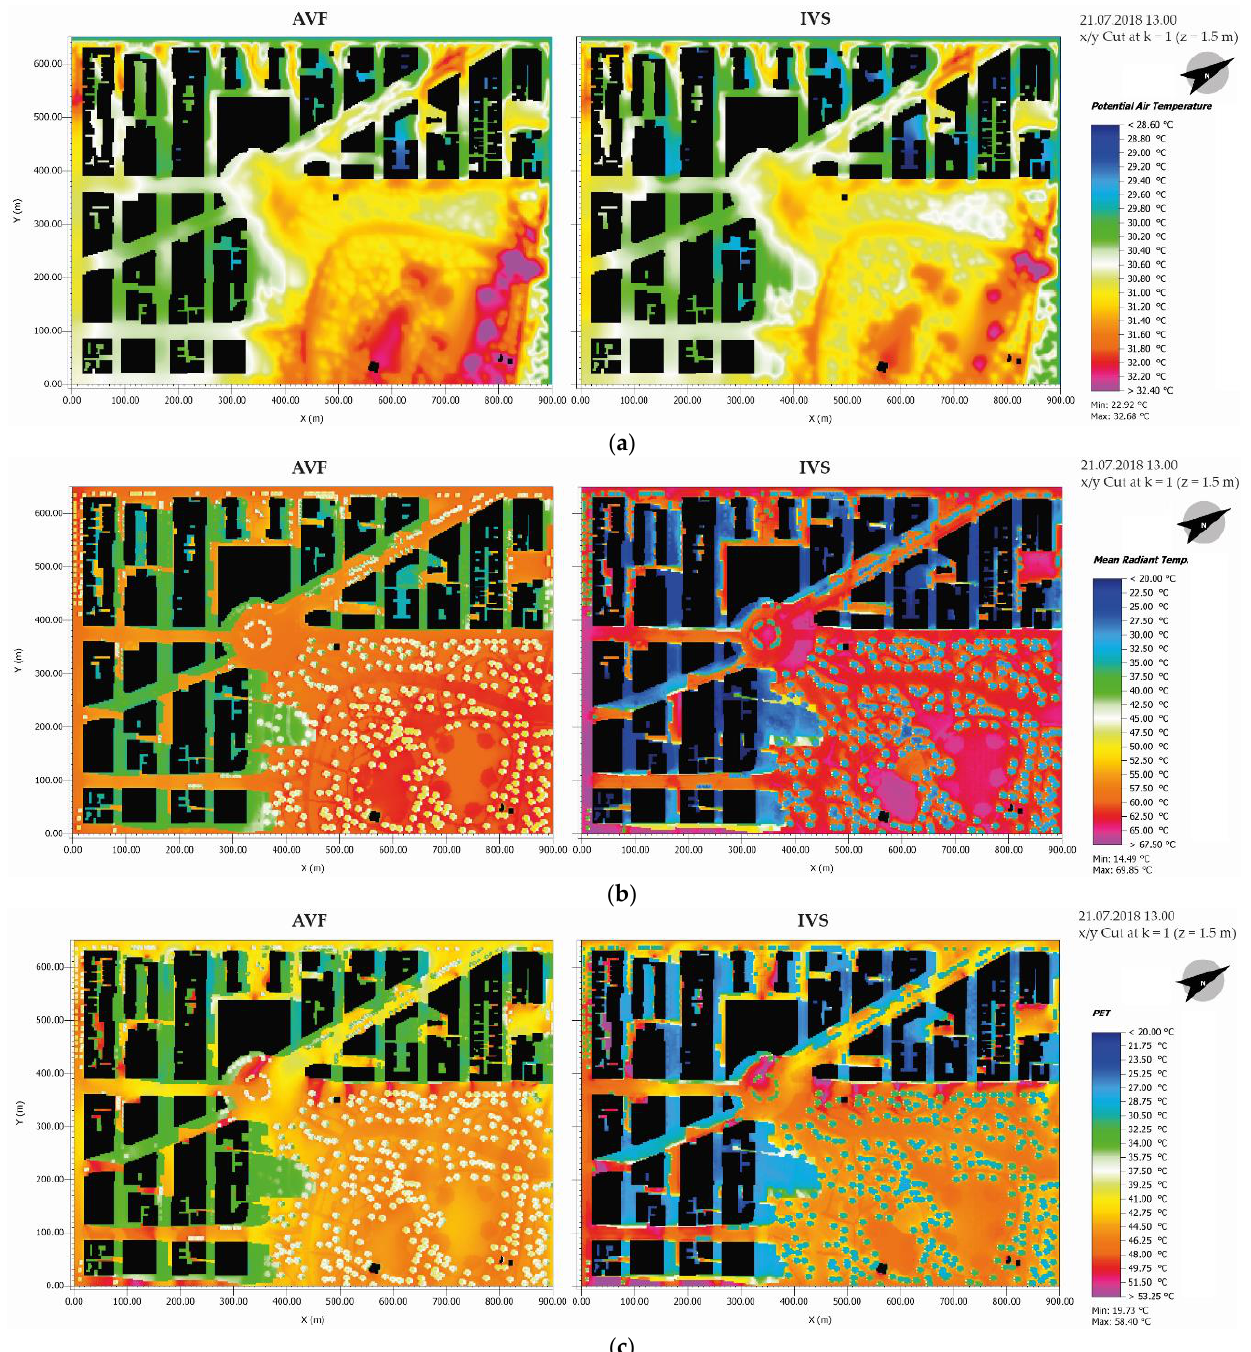
Figure 8. Comparison of proof-of-concept simulation results between AVF and IVS at 13.00 in a height of 1.5 m for potential air temperature ( a ), for mean radiant temperature ( b ), and for PET ( c ), respectively.